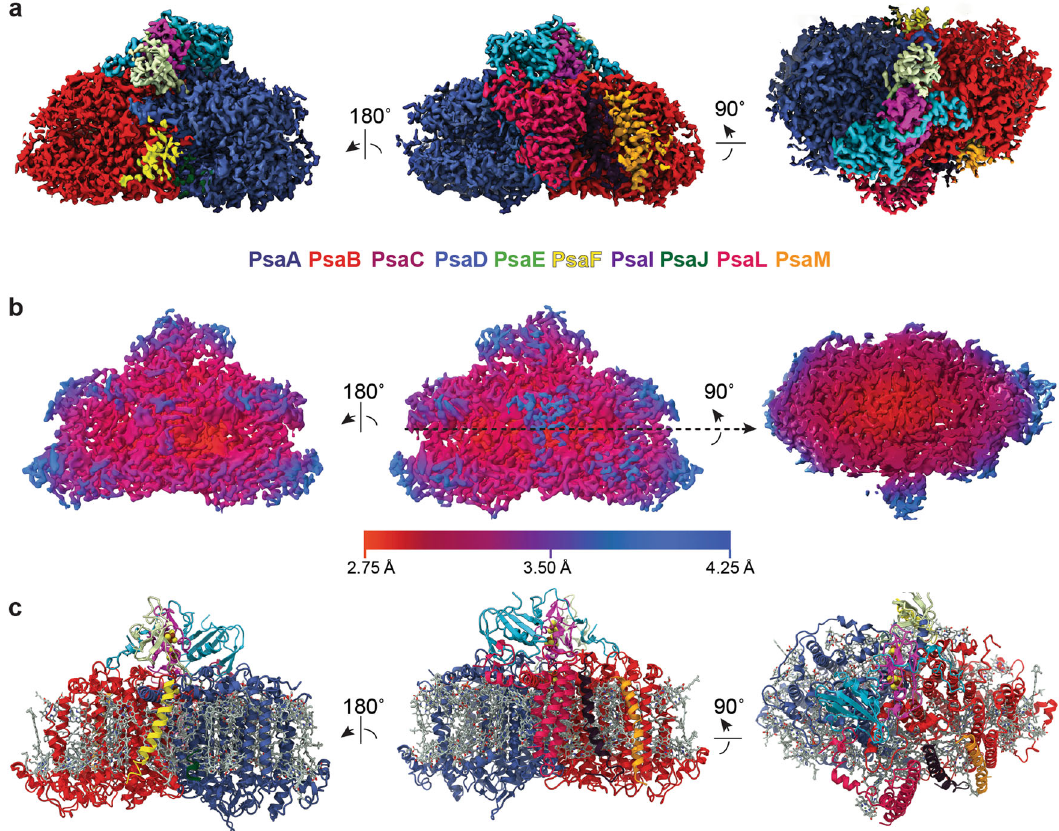
Fig. 3 Overall structure of the PSI monomer from T. elongatus . a The 3D cryo-EM Coulomb density map of the PSI monomer viewed parallel to membrane from the membrane side (left), trimerization side (middle), and viewed along the membrane normal from the stromal side. Map regions are colored according to the fi tted model following the color scheme indicated by the subunit name font color. b Local resolution map of the PSI monomer viewed parallel to membrane from the membrane side (left), trimerization side (middle), and viewed along the membrane normal from the stromal side. Coloring by local resolution as indicated. c The structural model of the PSI monomer viewed parallel to membrane from the membrane side (left), trimerization side (middle), and viewed along the membrane normal from the stromal side. Coloring of subunits as in a and cofactors in